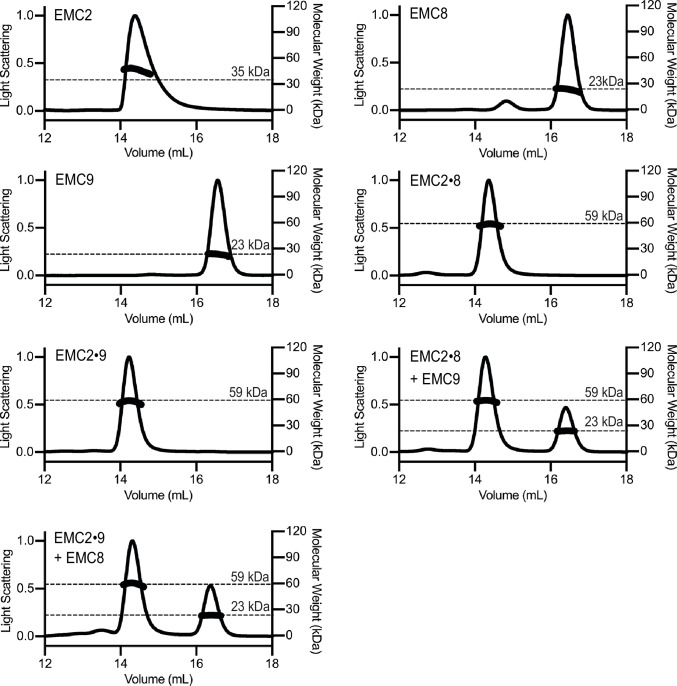
SEC-MALS of individual and complexed cytoplasmic EMC-subunits.Size Exclusion Multi Angle Light Scattering (SEC-MALS) analysis of recombinant EMC2, EMC8 and EMC9. The signal from the 90°-scattering detector is plotted on the left y-axis as a solid line and the calculated molecular weight is plotted on the right y-axis and depicted as points across the elution peak. A dotted line notated with text indicates the theoretical molecular weight for each protein. The calculated molecular weights are consistent with those predicted for monomeric subunits and complexed subunits. Neither addition of EMC8 to a preformed EMC2•EMC9 complex nor addition of EMC9 to a pre-formed EMC2•EMC8 complex resulted in the formation of a ternary complex.